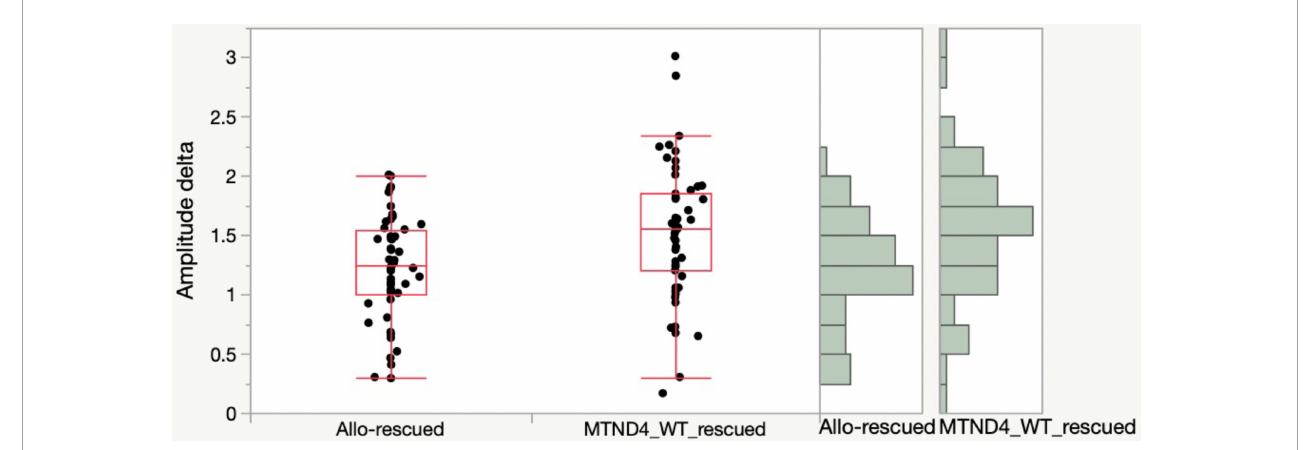
FIGURE4 Mito-targeted approach mediates a stronger rescue than allotopic strategy. PERG amplitude differences between rescued and unrescued mice are different from zero for both allotopic and mito-targeted approaches (both are effective in rescue) but the rescue effect is stronger with the mito-targeted approach (the distributions are significantly different for the two approaches, p = 0.0128).